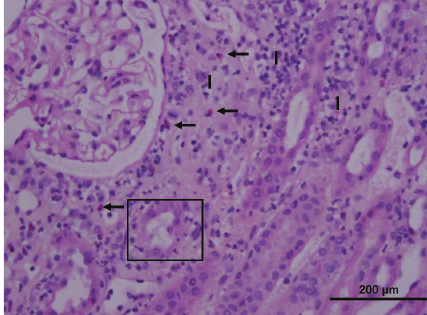
Figure 2: Photomicrograph showing active interstitial nephritis with acute tubulitis and mixed interstitial inflammation includ- ing numerous eosinophils. I: interstitial inflammation, arrows: eosinophils, and box: active tubulitis (H&E 30x magnification).